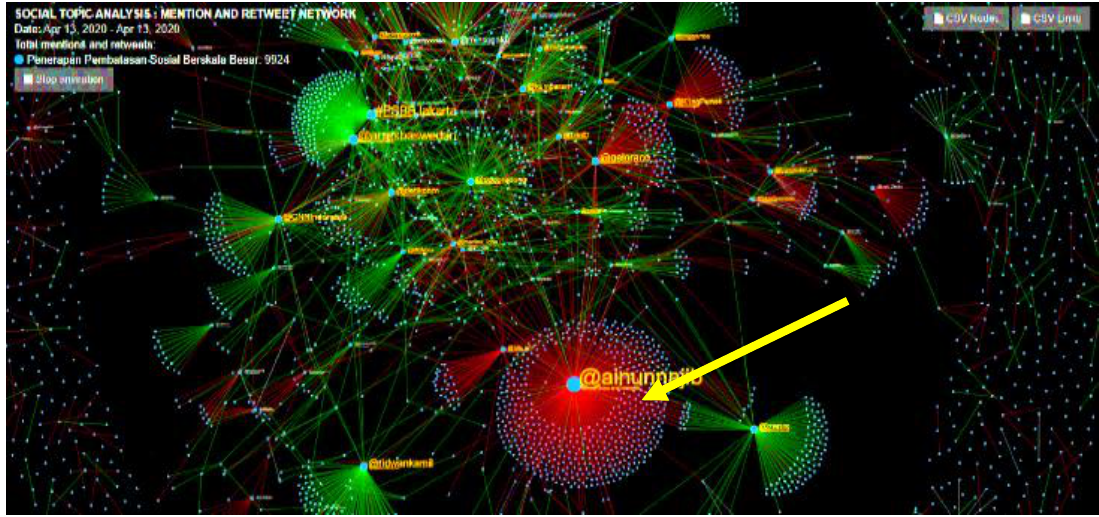
Figure 6. Social Network Analysis on 13 April 2020; the condition was recorded at 11:59 a.m.